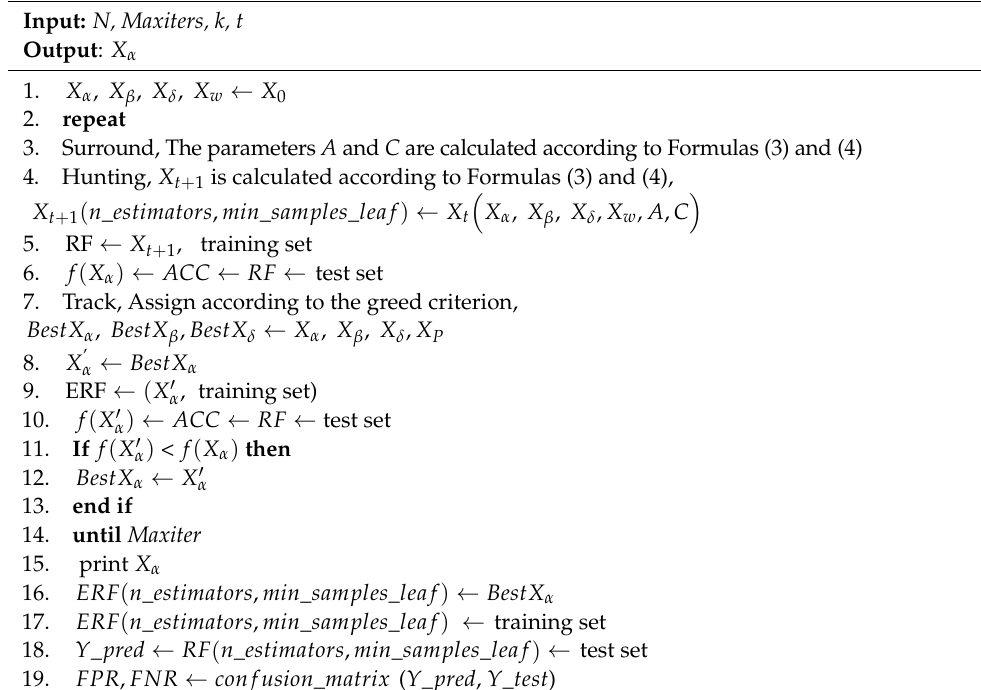
Algorithm 1. IGWO algorithm optimizes Extreme Random Forest